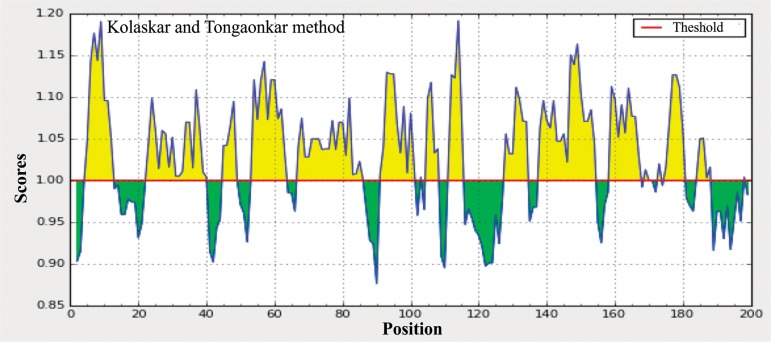
Kolashkar and Tongaonkar antigenicity prediction of the most antigenic regions of Arabian camel HSPB-1 protein.The threshold value is 1.0. The regions above the threshold are antigenic, shown in yellow.